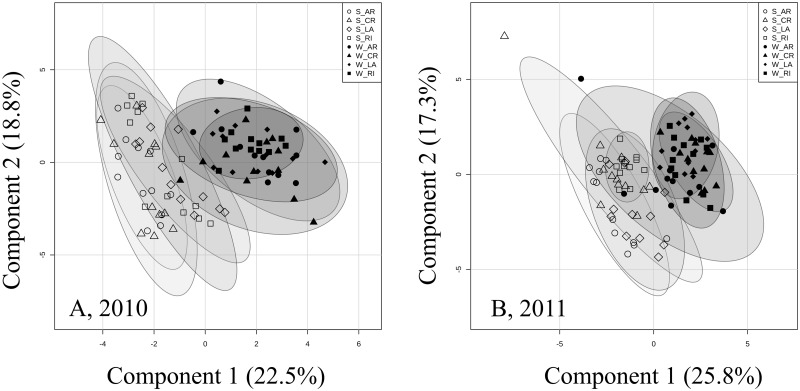
Clustering of N pools and free amino acids in needles of four Douglas-fir provenances.Sampling was done in May and July 2010 (A) and 2011 (B). Figures represent score plots of a partial least squares–discriminant analysis. Douglas-fir provenances (AR, Salmon Arm; CR, Conrad Creek; LA, Cameron Lake; and RI, Santiam River) are represented by different symbols, open and solid symbols indicate individual trees at field sites Schluchsee (S) and Wiesloch (W) irrespective of month of sampling. Semi-transparent shadings indicate 95% confidence regions.